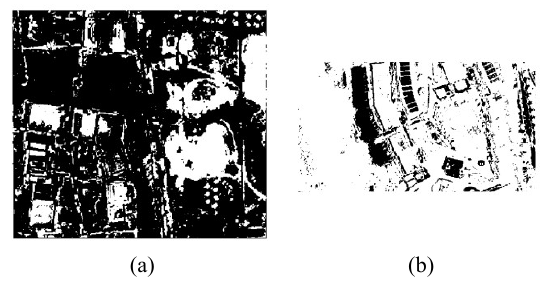
Figure 8. Change detection from the QuickBird image to the WorldView image of (a) “Scene 1” (b) “Scene 2” after 13 years have passed: White = change, Black = no change (Celik,